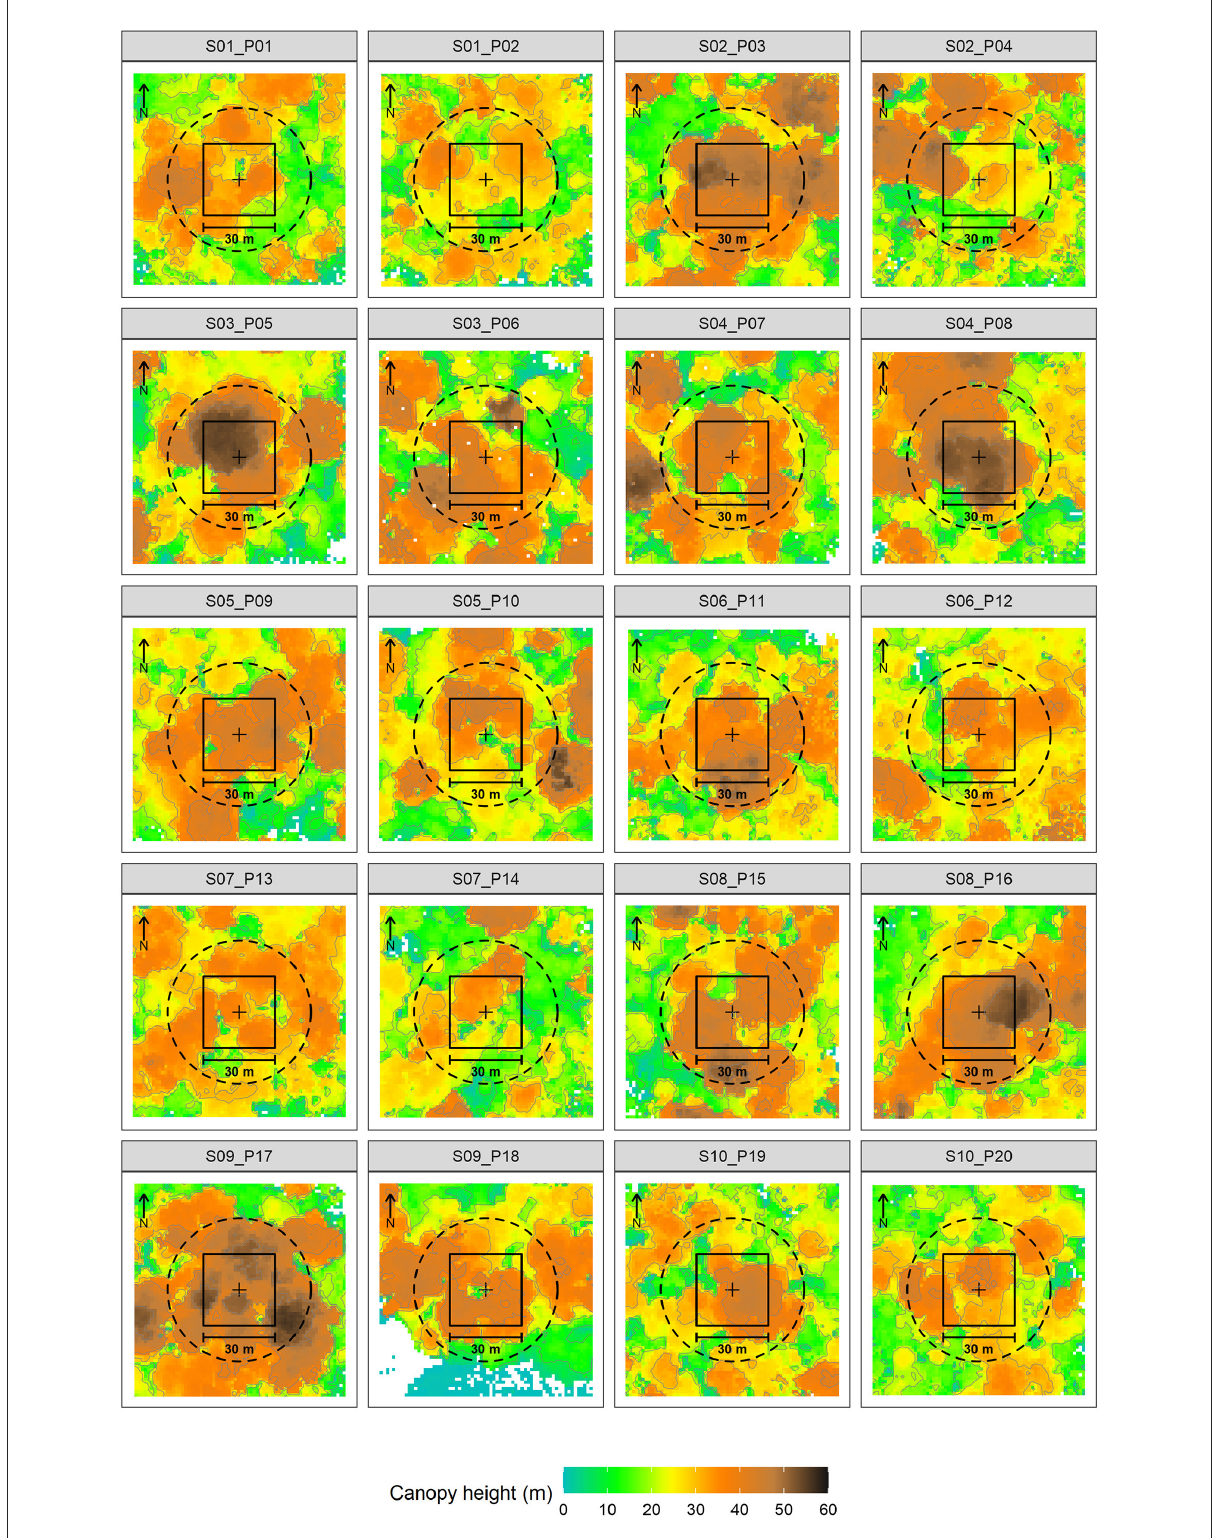
FIGURE8 Color-coded canopy heights at TLS captured sites. Black line marks the 30 m*30m plot boundary, dashed line marks a 30m radius around the plot center (black cross). Site and plot numbers are given in the